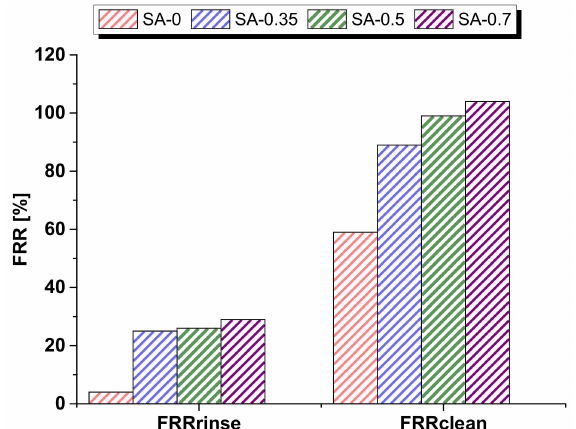
Figure 12. Dependence of FRR of the reference SA-0 and PAA-modified membranes after ThMP process water ultrafiltration on the cleaning technique: deionized water rinsing (FRR rinse ) and alkaline chemical cleaning (FRR clean ).